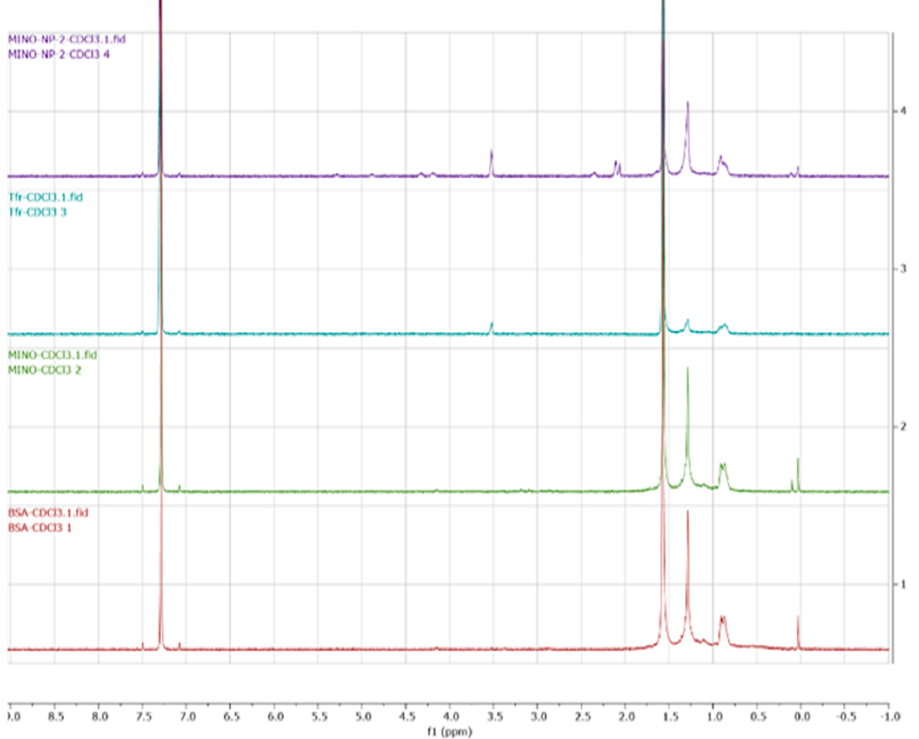
Figure 4. NMR spectra of BSA, Transferrin, minocycline, and tfMANP conjugates.